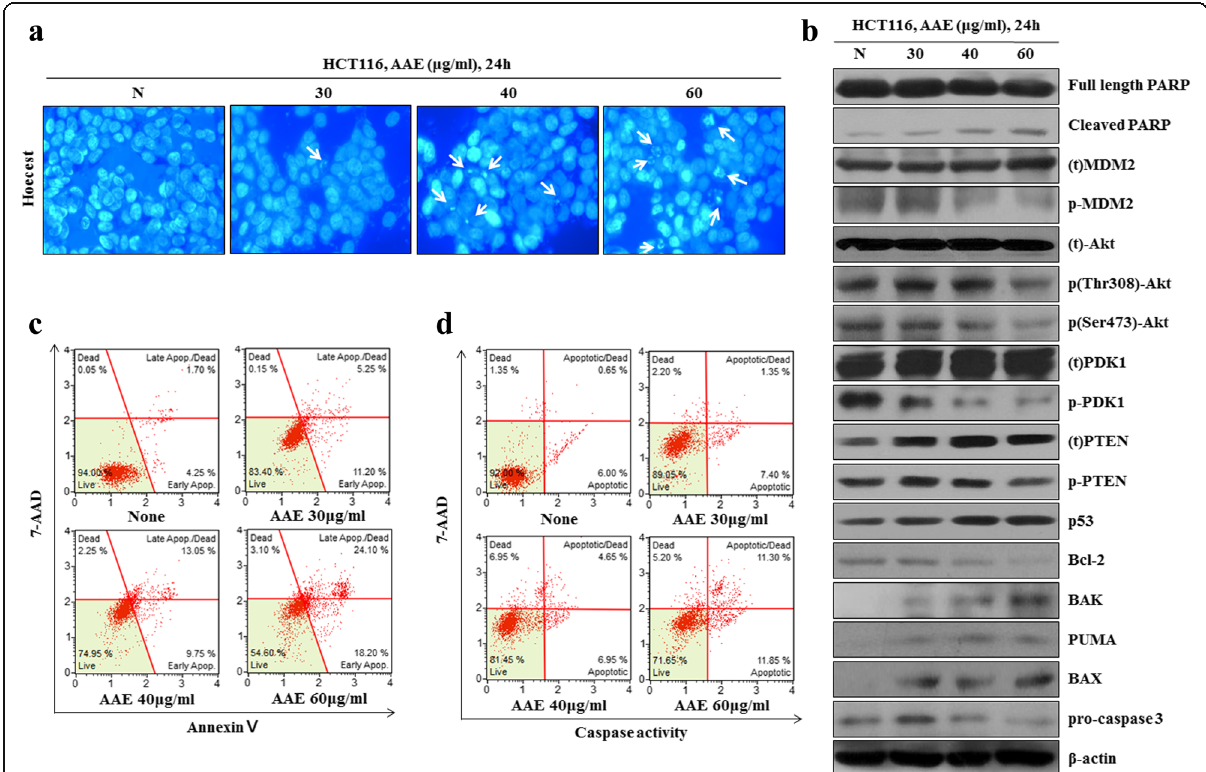
Fig. 2 AAE induces apoptosis and regulates pro-apoptotic proteins in HCT116 colon cancer cells. a Cell apoptosis observed using Hoechst 33342 staining. HCT116 were treated with AAE (0, 30, 40, and 60 ìg/ml) for 24 h. Fluorescence was detected using a fluorescence microscope. Arrows indicate apoptotic bodies, which were DNA fragments produced when apoptosis occurred. b Apoptotic effects of different concentration AAE were evaluated by Muse ™ Annexin V and Dead Cell Assay Kit. HCT116 were treated with AAE (0, 30, 40, and 60 ìg/ml) for 24 h. Data analyzed by flow cytometry. c HCT116 were treated with 0, 30, 40, and 60 ìg/ml of AAE 24 h, caspase 3/7 activity was analyzed using a Muse ™ Caspase-3/7 kit, as described in Materials and Methods. d Cells were treated with the indicated concentrations of AAE for 24 h. The expression of PTEN, PDK1, Akt (Thr308 and Ser473), MDM2, p53, PUMA,Bcl-2, pro-caspase3 and the activation of Bax, Bak and cleaved PARP were analyzed by western blot